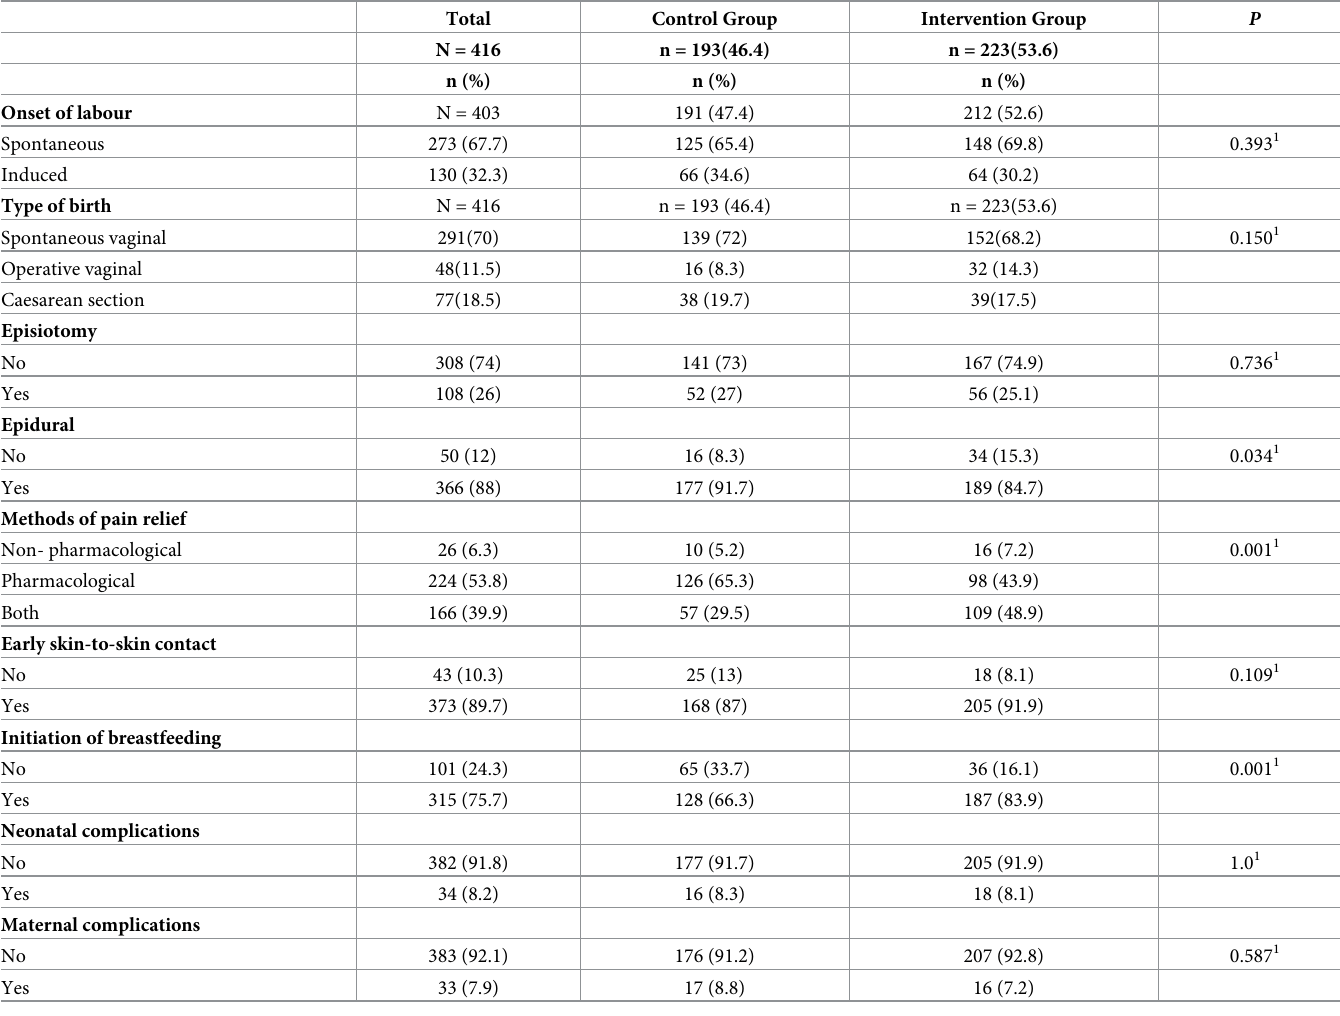
Table 3. Counselling intervention and obstetric results in both study